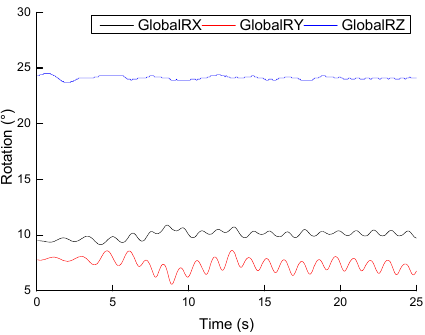
Figure 13. Test under the third working condition.